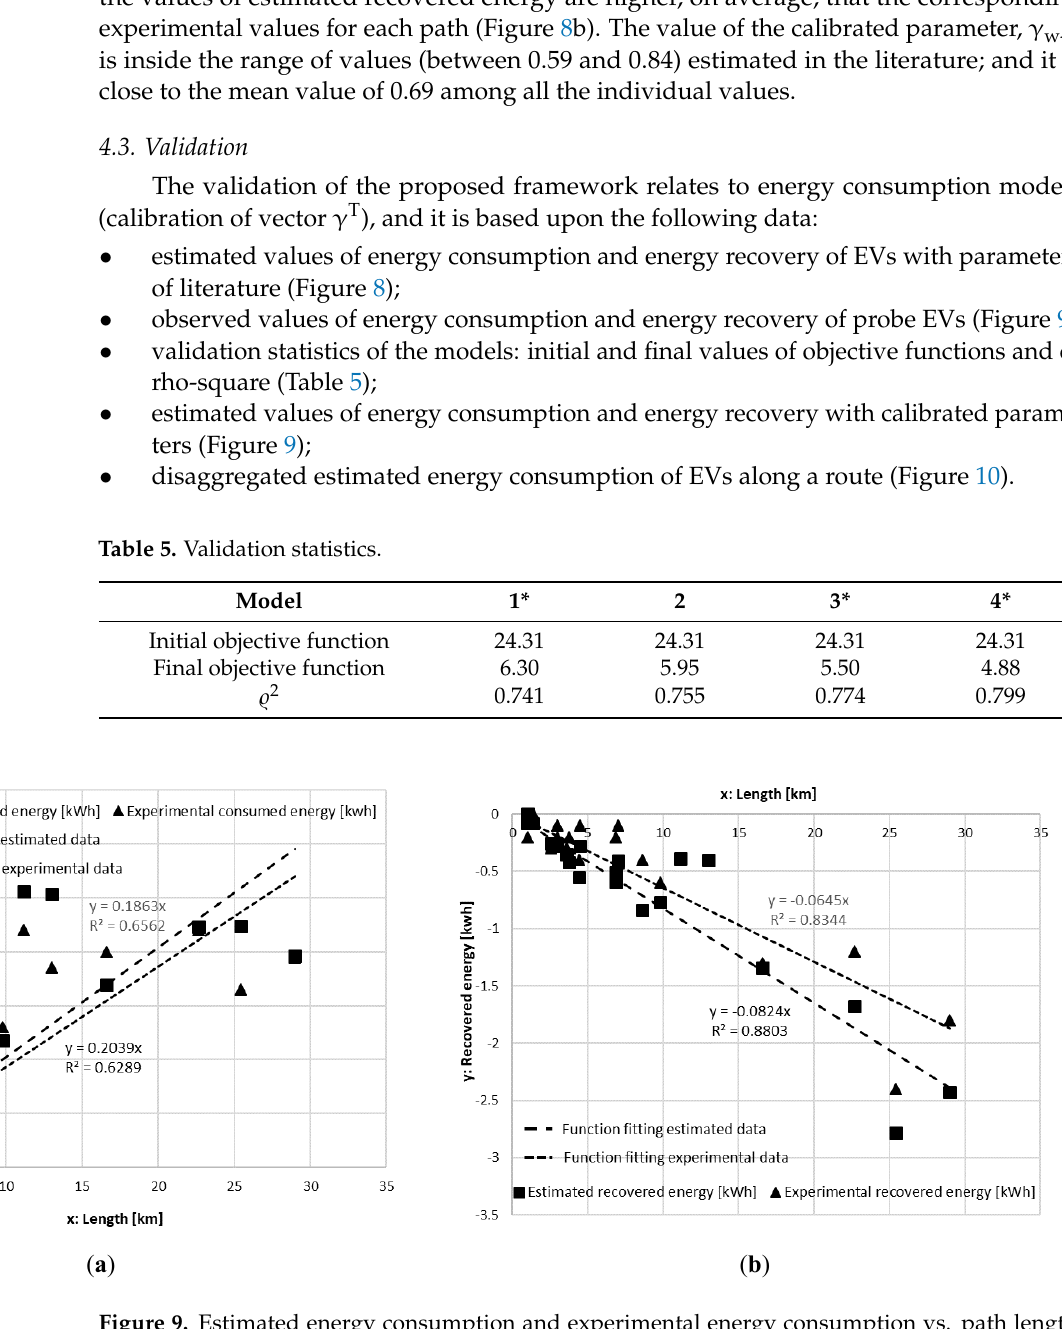
Figure 9. Estimated energy consumption and experimental energy consumption vs. path length: consumed energy ( a ) and recovered energy ( b ).